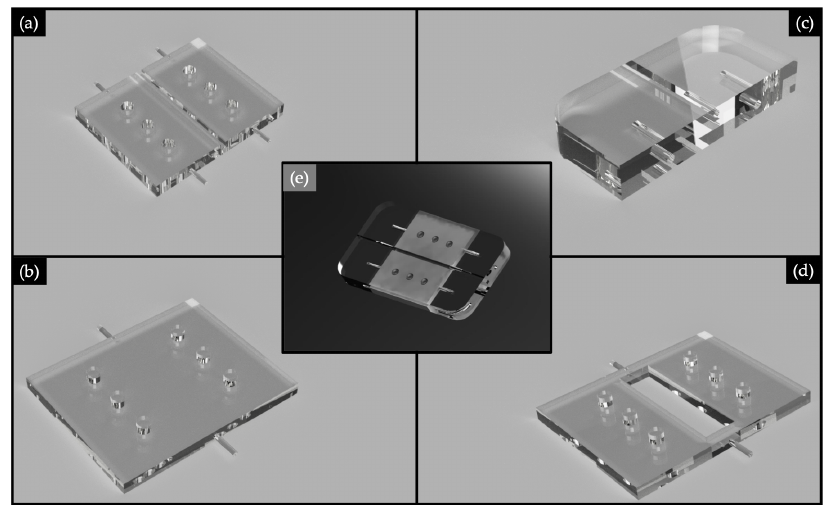
Figure 3. Rendering of the: substrate ( a ), cover ( b ), plastic optical fibers’ (POFs’) support ( c ), mask ( d ) and assembled device ( e ).